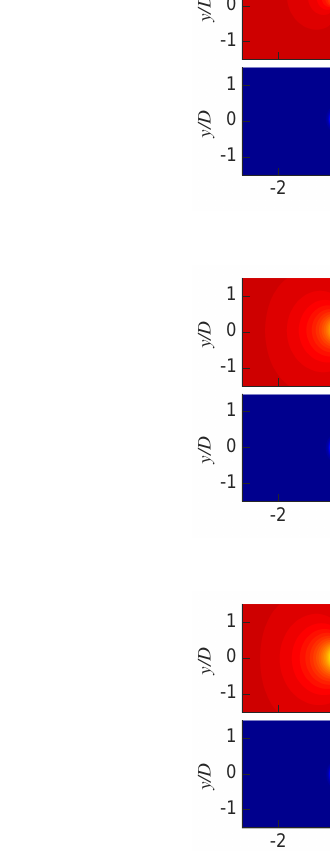
Figure 7. H-type VAWT with AR = 1 . 5: mean streamwise velocity ¯ u/U ∞ and resolved turbulent kinetic energy ¯ k = u y/D = 0